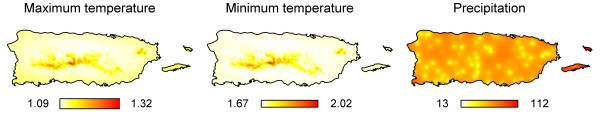
Prediction error by location. Mean standard deviation for Tmax (linear model, °C), Tmin (linear model, °C), and precipitation (Bayesian kriging model, mm) predictions at 1,000 meter resolution.